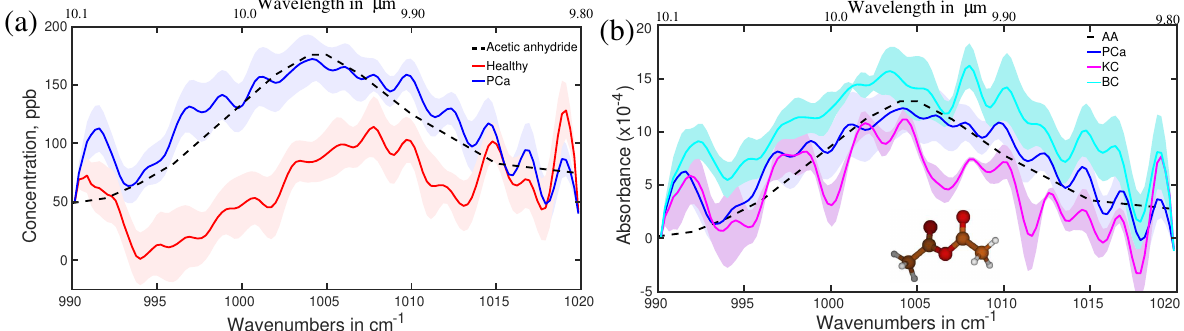
Figure 11. ( a ) Average absorption spectra of the healthy (red) and prostate cancer (blue) volunteers. The shaded plots are from each individual in respective sample groups. Dashed line: fitting curves of acetic anhydride, identified as biomarker. ( b ) Average absorption spectra of the prostate cancer (blue), bladder cancer (cyan), and kidney cancer (violate) patients. The molecular structure of acetic anhydride is presented as a ball-and-stick model. (Ref.[158]).